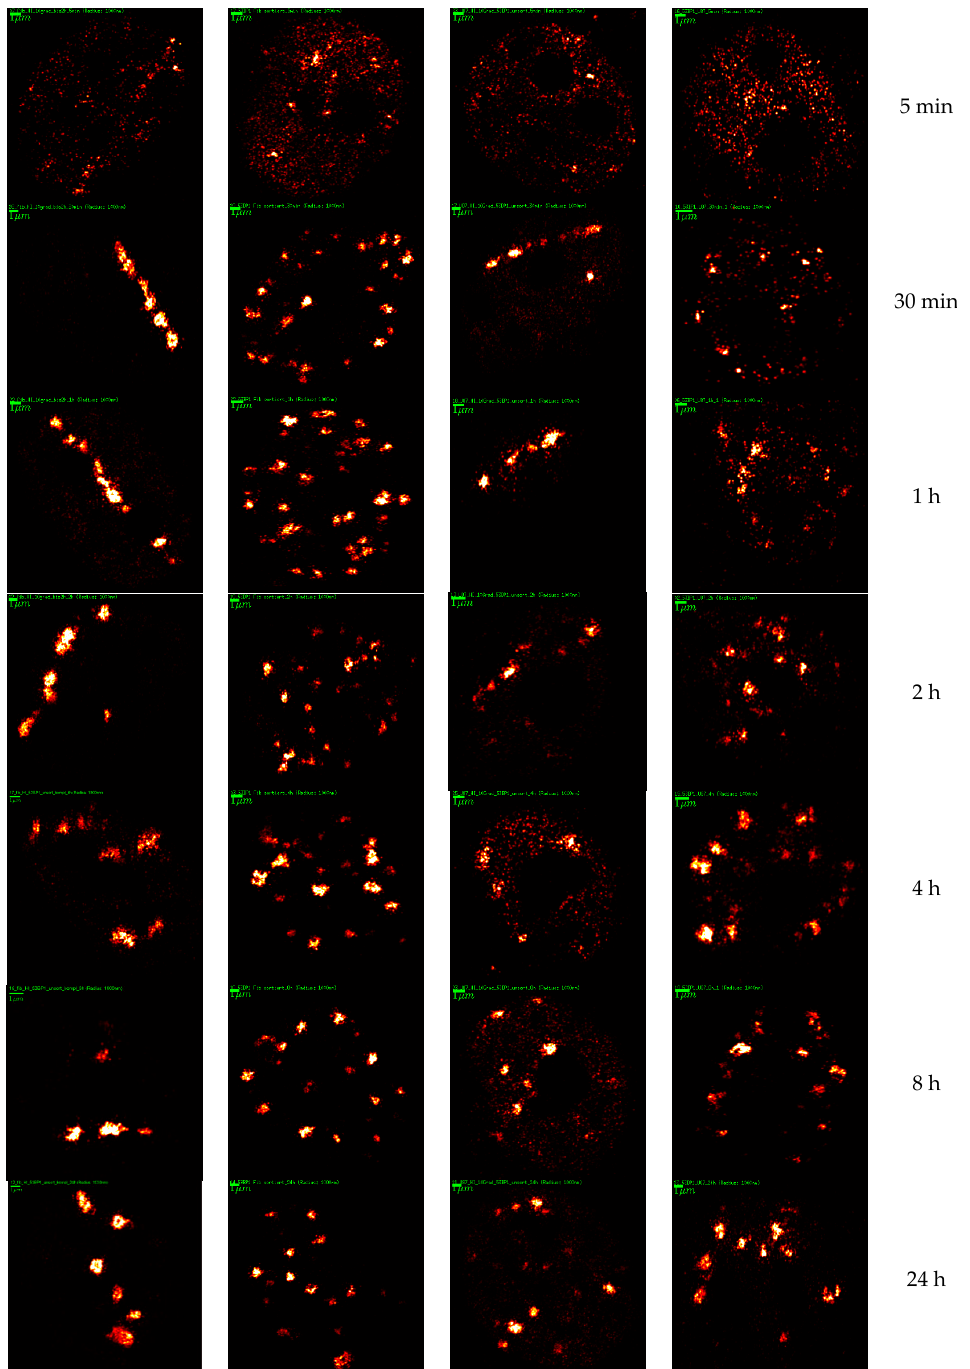
Figure 2. 2D density SMLM images of 53BP1 repair proteins. Typical examples are shown for fluorescently-labeled 53BP1 proteins in NHDF cells ( A , B ) and U87 cells ( C , D ) after 1.3 Gy tangential 15 N-irradiation ( A , C ) (10° angle between the ion beam and the cell layer) and 4 Gy perpendicular 15 N-irradiation ( B , D ) (90° angle between the ion beam and the cell layer). Along this time line, the samples were taken as aliquots of the same culture and fixed at different time points (5 min, 30 min, 1 h, 4 h, 8 h and 24 h) after irradiation. For comparison, examples of non-irradiated control cells are presented. The density images do not show all signal points detected but instead encode the number of neighbors of each signal within a circle of 1 µm radius by the point intensity—the number of signals in the given surroundings around one signal grows as the color of the point changes from red to white. The green bars equal to 1 µm.